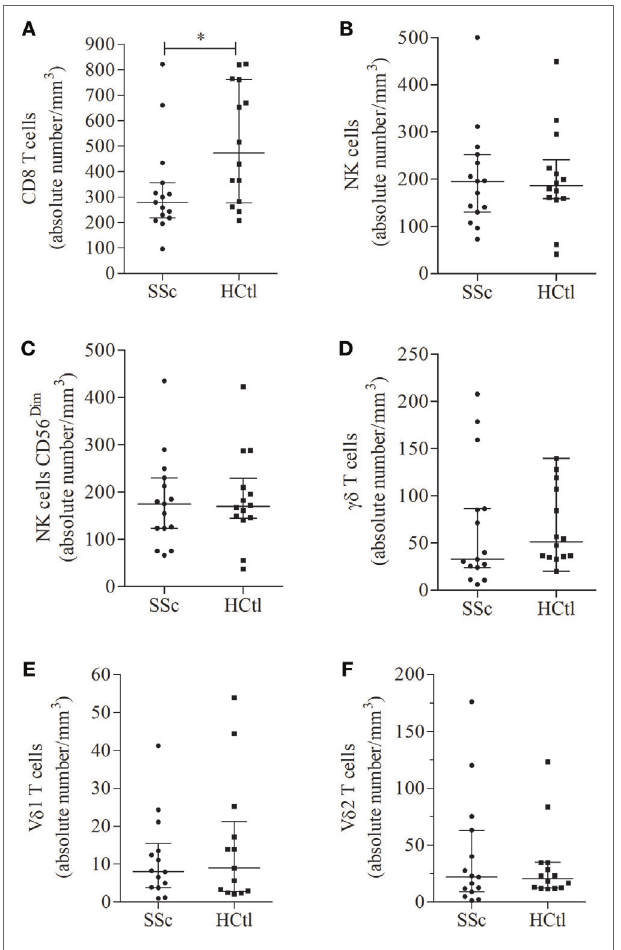
FigUre 1 | Number of circulating cytotoxic immune cells in systemic sclerosis (SSc) patients. Percentages of circulating immune cells were assessed in the peripheral blood of SSc patients ( n = 15) with flow cytometry and compared with healthy controls (HCtl) ( n = 14). Absolute numbers of circulating cells including CD8 T cells (a) ; natural killer (NK) cells (b) ; NK cells CD56 dim (c) ; γδ T cells (D) ; V δ 1 (e) ; and V δ 2 T cells (F) were obtained based on the white blood lymphocyte count and expressed as number of cells per mm 3 . Results were expressed as median ± interquartile range. Statistical difference was established using Mann–Whitney U test. * p <